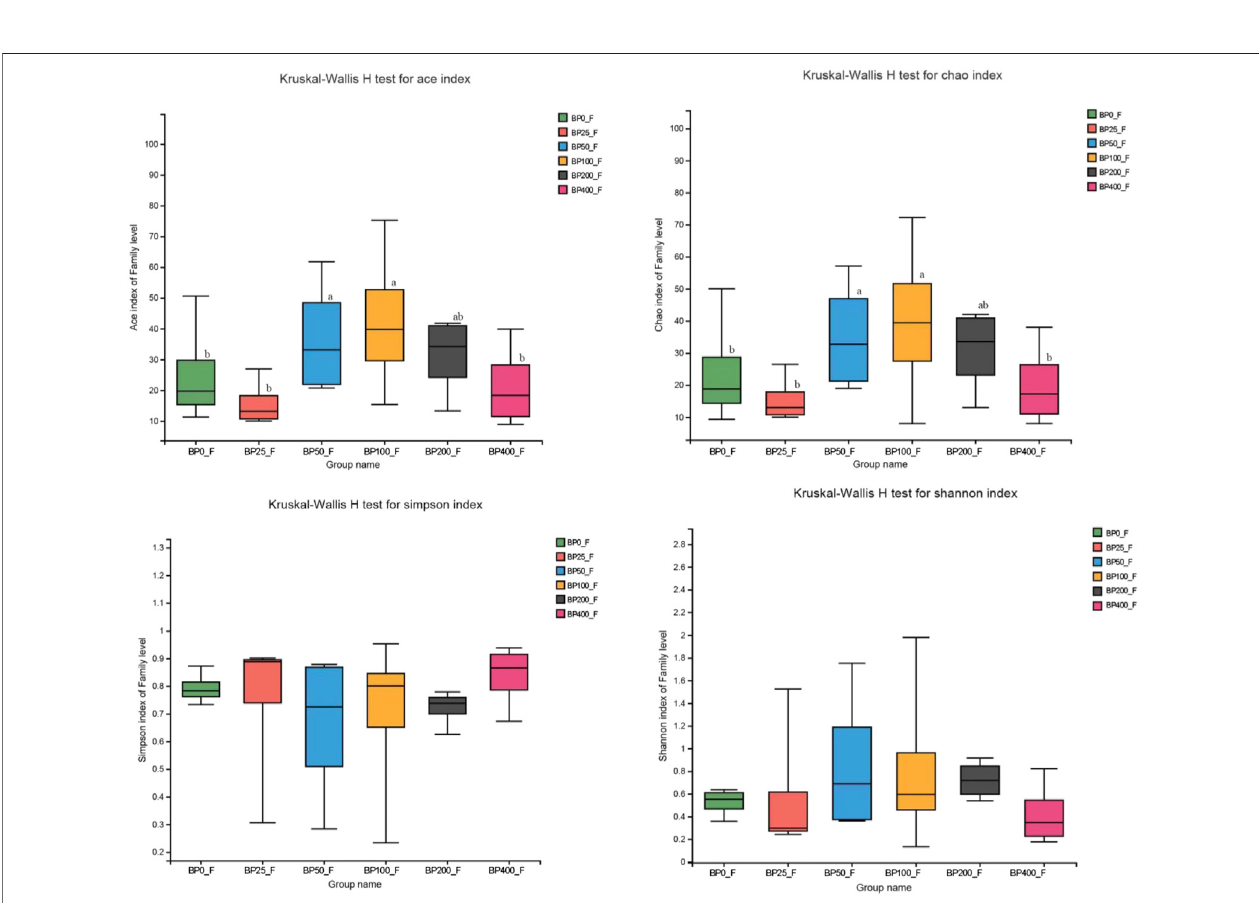
FIGURE 2 | Alpha diversity analysis in